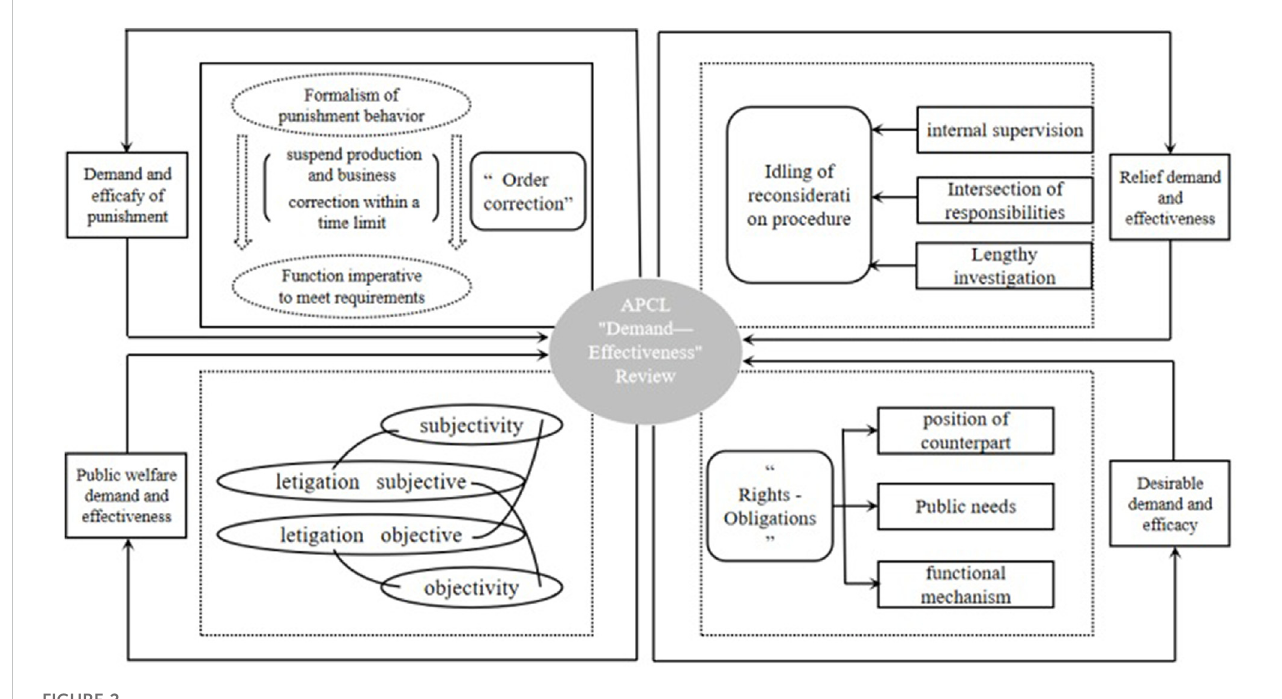
FIGURE 2 The road map of “ demand-effectiveness ” actual Inspection of